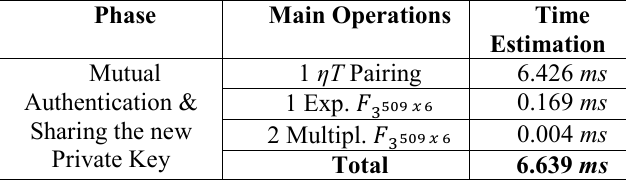
TABLE I. Estimation of RFID-Tate computation